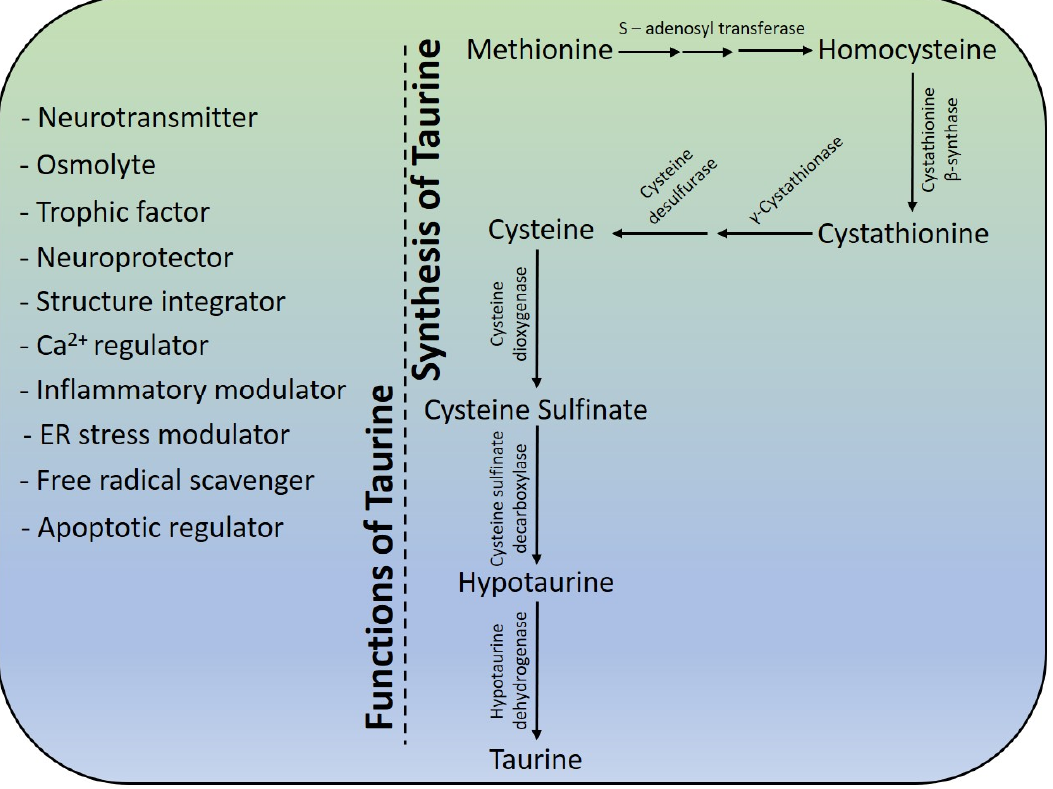
Figure 3. Structural and functional aspects of osmolyte taurine.